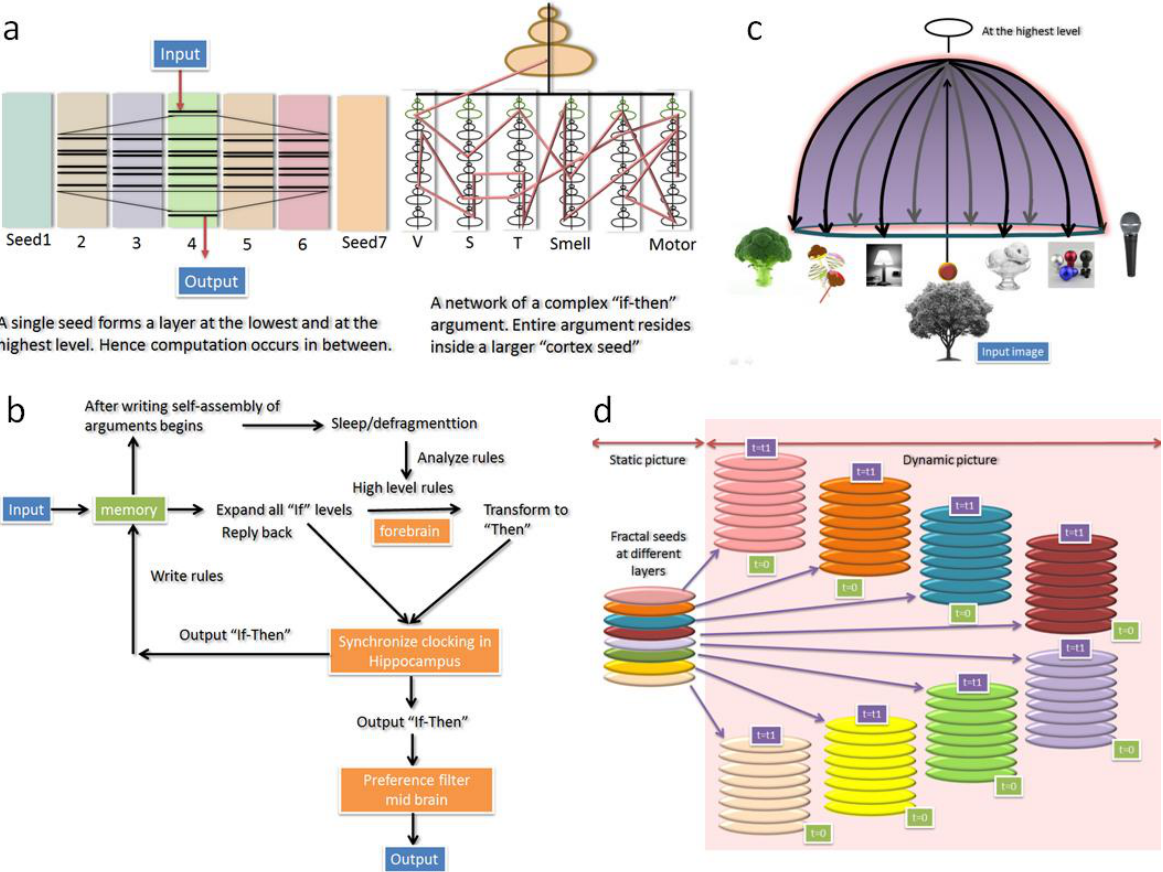
Figure 14. ( a ) The plot on the left shows how input image distributes as fractal seeds, in five layers, before sending the output. The plot right shows how multiple sensory domains with distinct resonance chains hold a complex ―if-then‖ argument; ( b ) The complete operational protocol for the decision making in our computer; ( c ) Tree is resolved into a geometric shape at the top which triggers several similar objects (umbrella route); ( d ) Each layer has its own dynamic stack of layers, and those dynamics layers couple during computing, the network between dynamic layers are not shown for clarity. The temporal stacks couple in astronomical